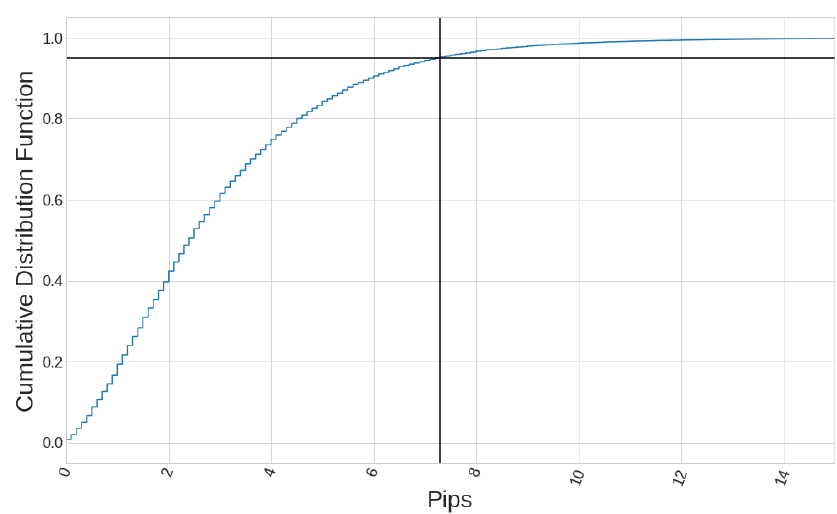
Figure 8. The volatility of EURUSD in the 1-min timeframe experiences values above v th = 7.3 pips just 5% of the time for the period